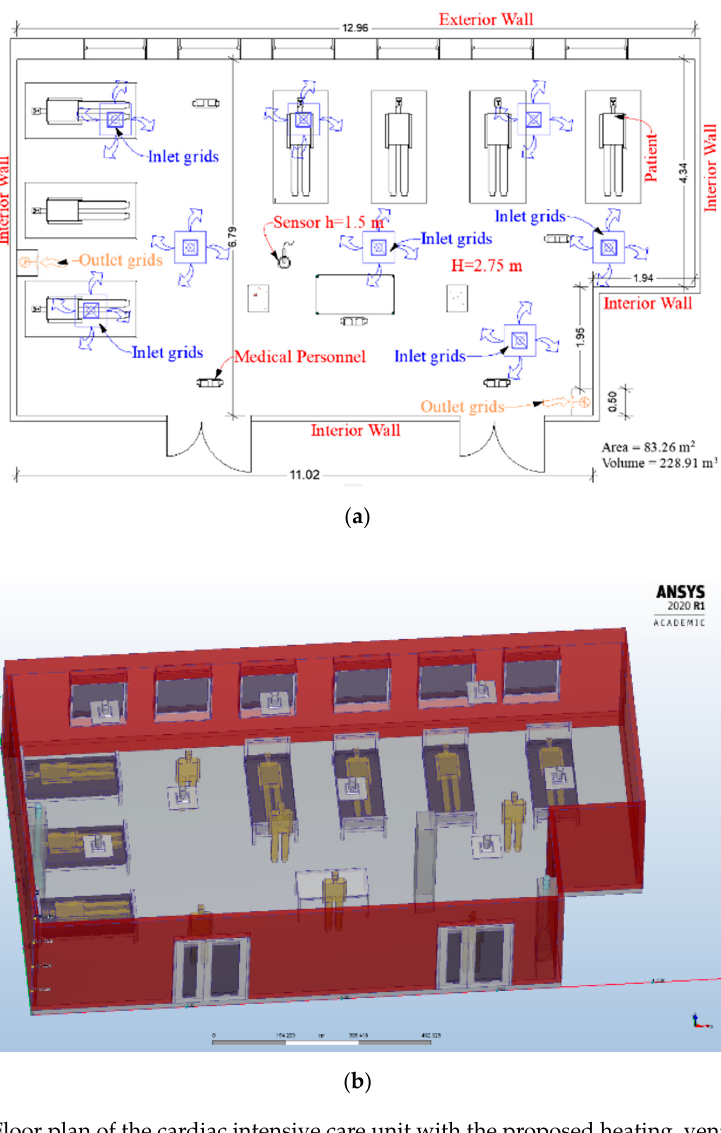
Figure 1. ( a ) Floor plan of the cardiac intensive care unit with the proposed heating, ventilation and air conditioning system (HVAC); ( b ) the proposed three-dimensional (3D) model of the cardiac intensive care unit from Ansys 2020 R1